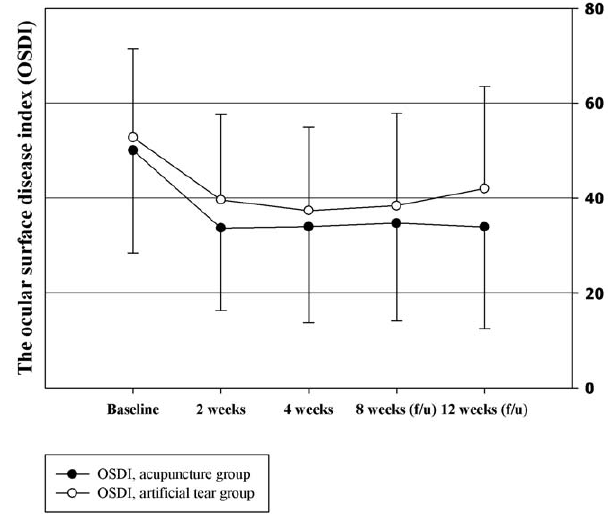
Figure 2. Ocular surface disease index (OSDI). doi:10.1371/journal.pone.0036638.g002 PLoS ONE |